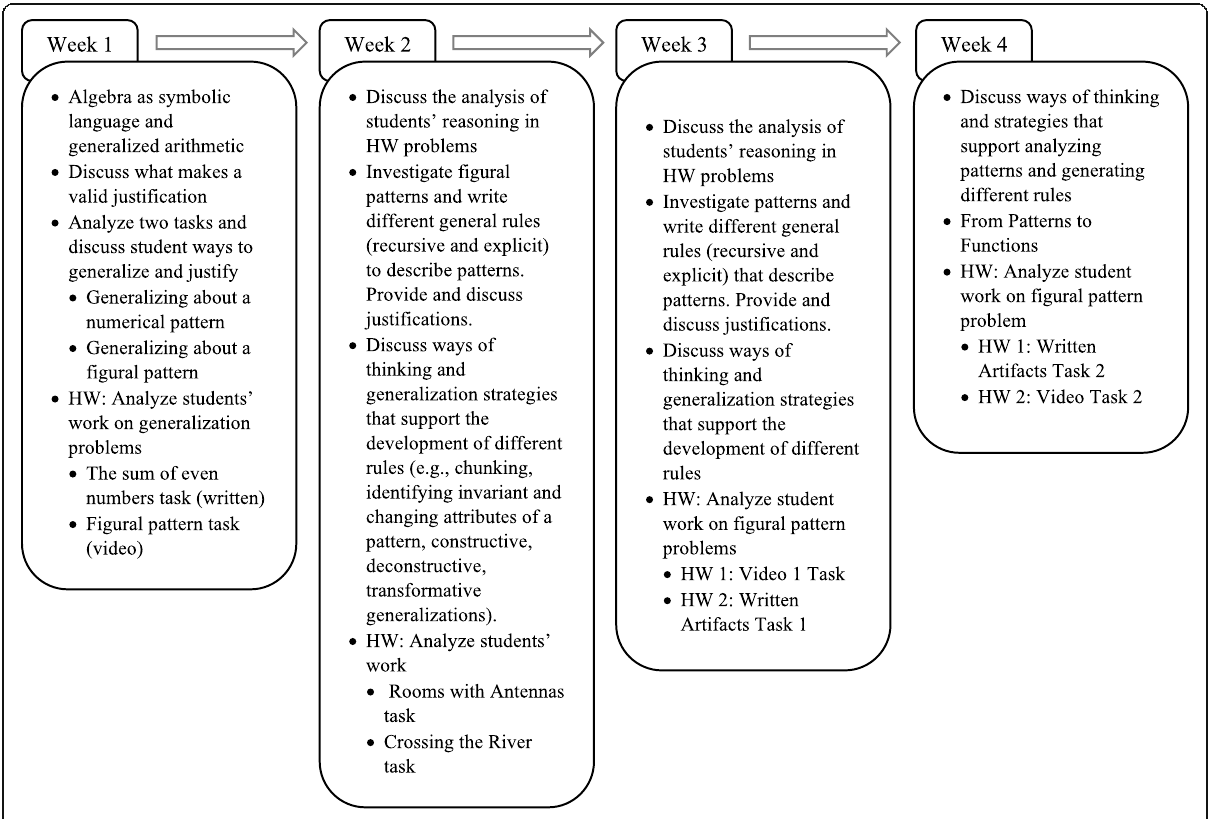
figural patterns. We designed the tasks to highlight dif- ferent ways of reasoning, a variety of generalization strategies, as well as valid, invalid, or incomplete justifi- cations. Two tasks contained short video clips of stu- dents who shared their reasoning in small groups. The other two tasks included students ’ written work, which we selected to document students ’ reasoning about fig- ural patterns. We provided PSTs with sufficient time to complete each task. They could revisit student strategies by watching each video clip or examining written arti- facts of students ’ work as many times as they needed to understand and make sense of students ’ thinking. The tasks (Figs. 2, 3, and 4) were introduced in the following order: video 1, written artifacts 1, written artifacts 2, and video 2. We presented PSTs with our tasks after the ini- tial class sessions during which PSTs engaged in the practice of generalizing and justifying, discussed explicit and recursive generalization strategies and features of valid